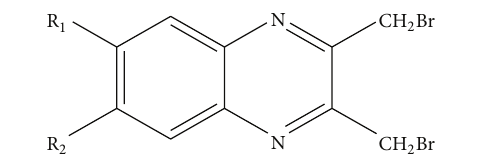
Figure 4: Chemical strucure of compound 9a – l .